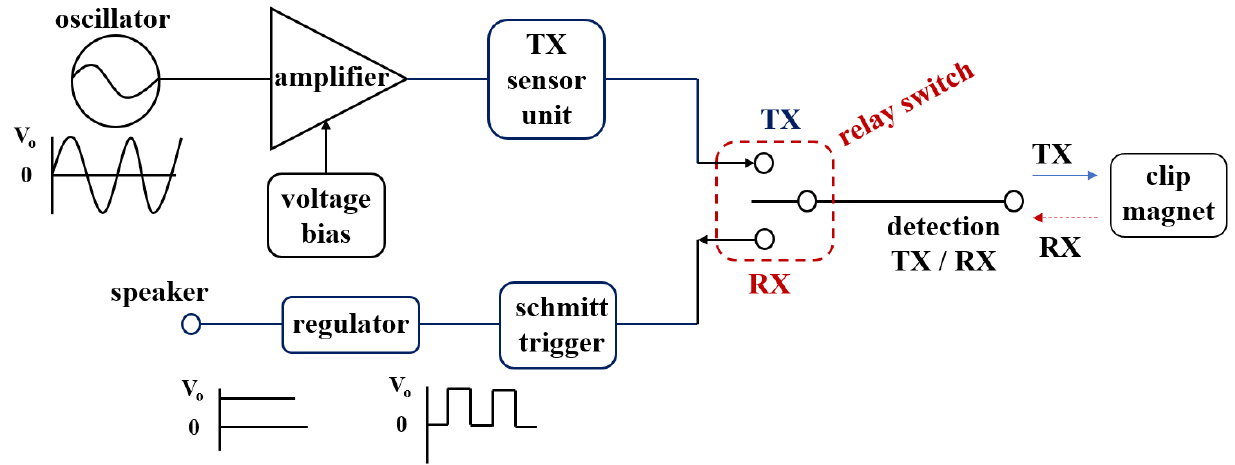
Figure 2. Block diagram of the clip – detector.